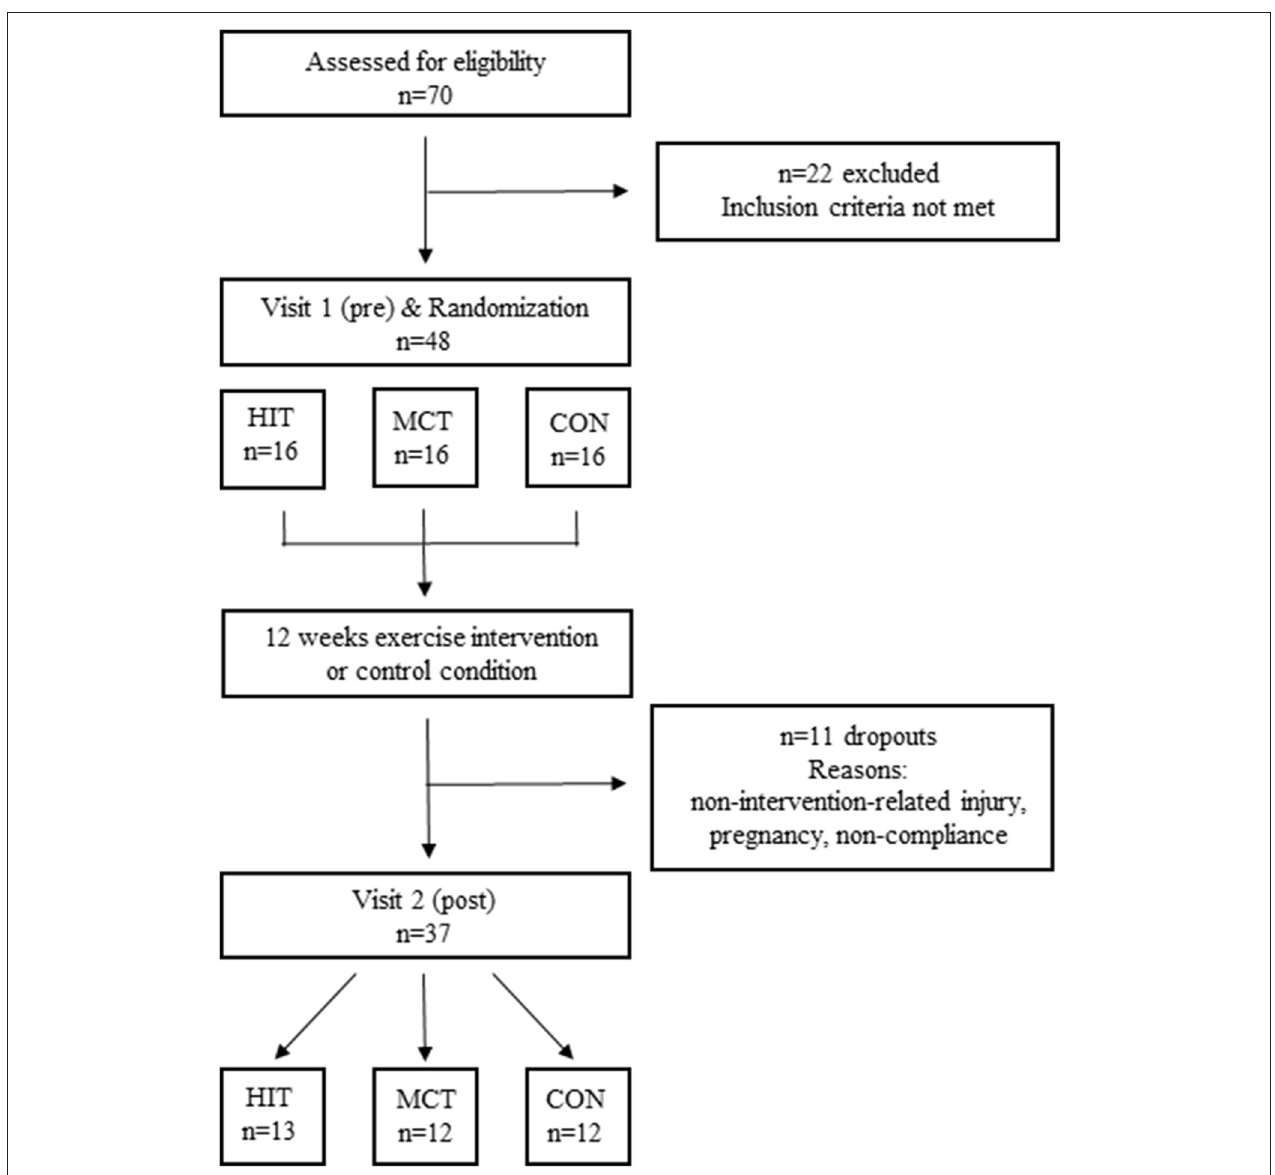
FIGURE 1 | Flow-chart of the randomized controlled trial.